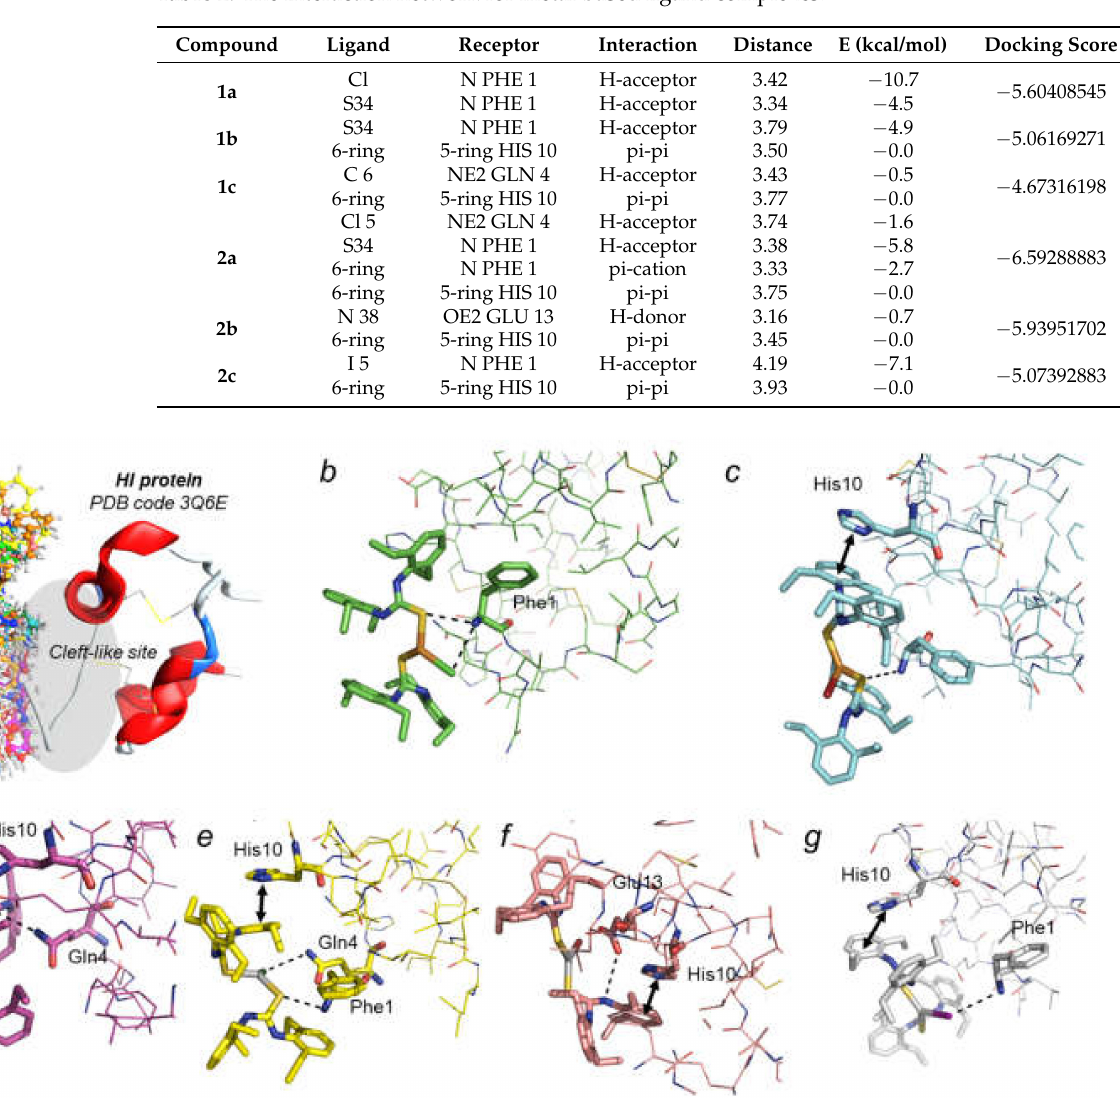
Table 2. The interaction network for metal-based ligand complexes.